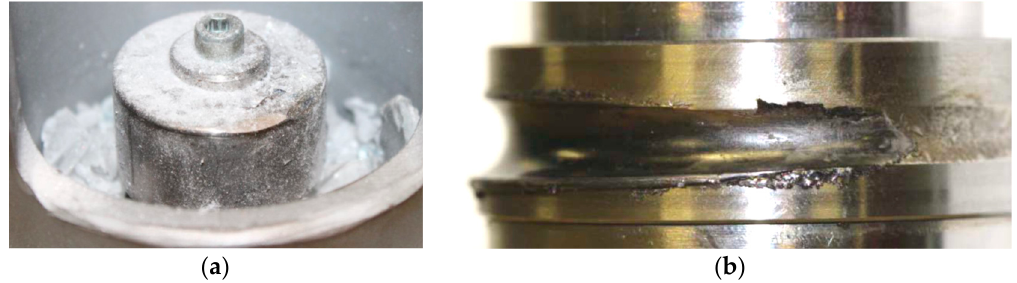
Figure 6. ( a ) Broken magnetic coupling in glass debris of containment shroud; ( b ) damaged bearing race.